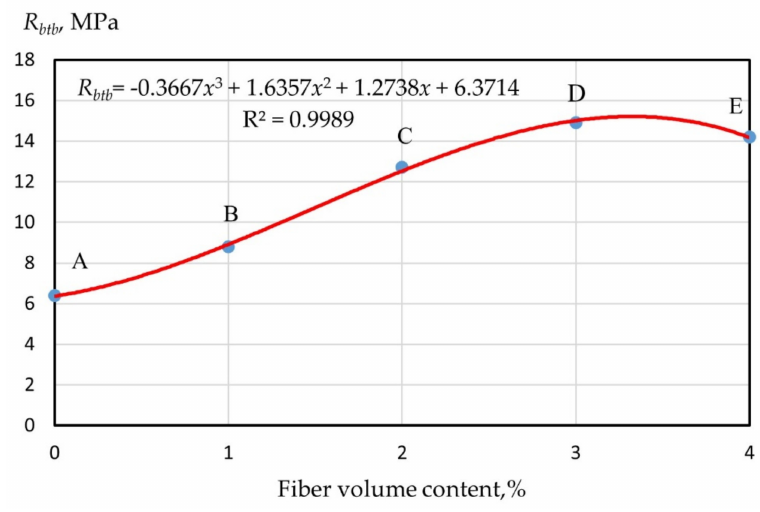
Figure 4. Dependence of the strength of monodispersion-reinforced fiber cement specimens on the volumetric content of glass fiber type B.